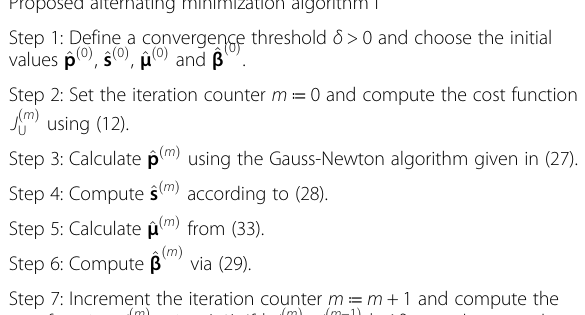
Proposed alternating minimization algorithm